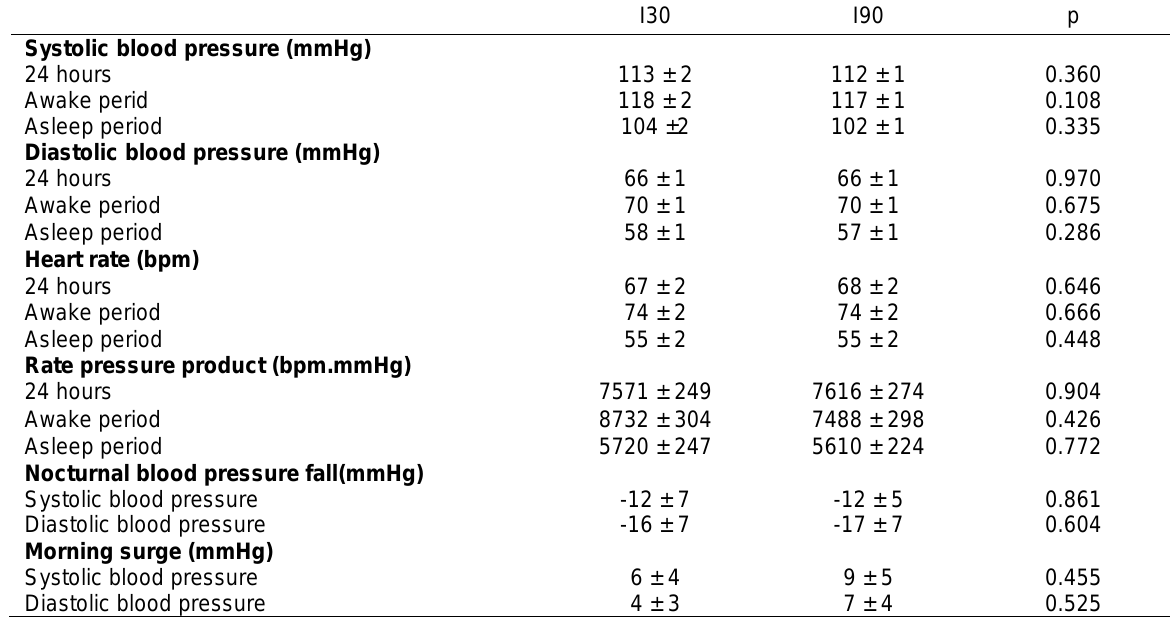
Table 2. Ambulatory responses after resistance exercise performed with 30 seconds of rest interval (I30) and 90 seconds of rest interval